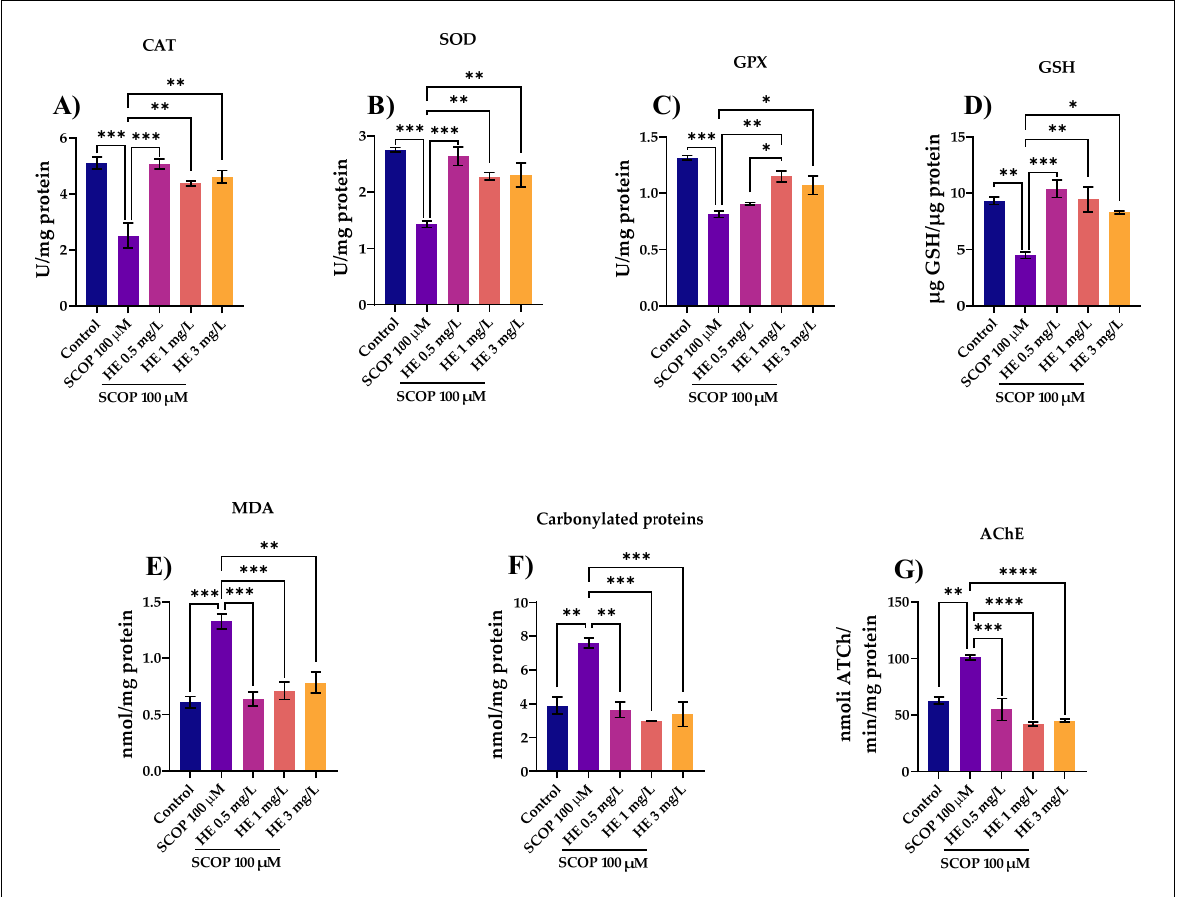
Figure 5. Hericium erinaceus ethanolic extract (HE: 0.5, 1, and 3 mg/L) exhibited an anti-AChE effect and improved the antioxidant status in the zebrafish brain. ( A – D ) Representation of the enzymes specific activity (CAT, SOD, GPX and GSH) in different groups; ( E , F ) Representation of the MDA and protein carbonyl levels in different groups; ( G ) AChE-specific activity. Values are means ± S.E.M. ( n = 10). For Tukey’s post hoc analyses: **** p < 0.0001, *** p < 0.001, ** p < 0.01, and * p < 0.05.